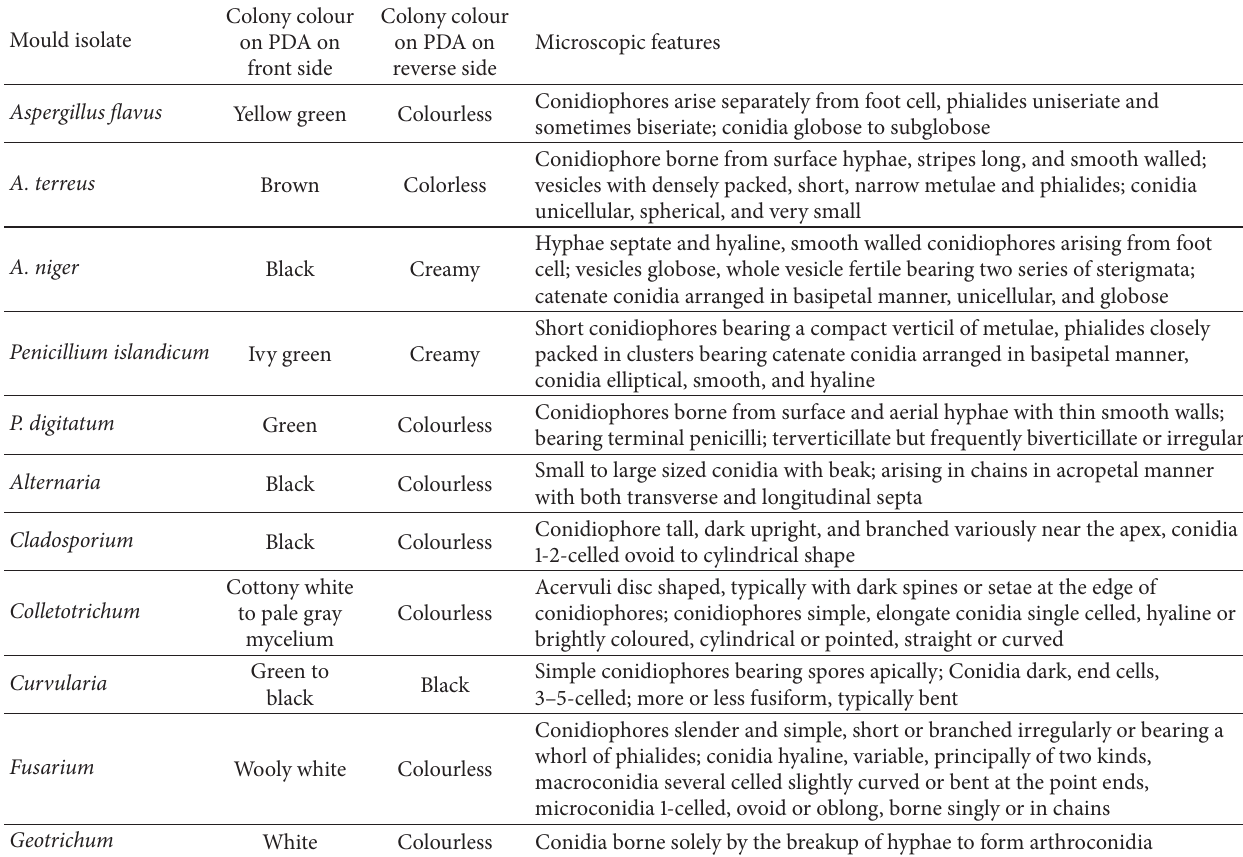
Table 6: Morphological details of mould isolates of juices.